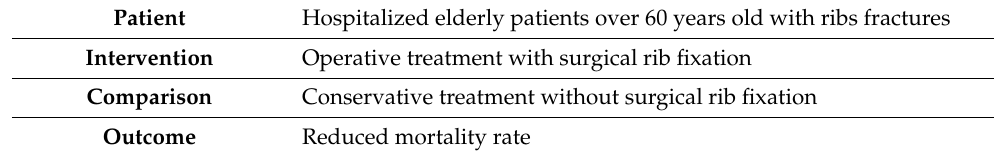
Table 1. PICO strategy used for the study.